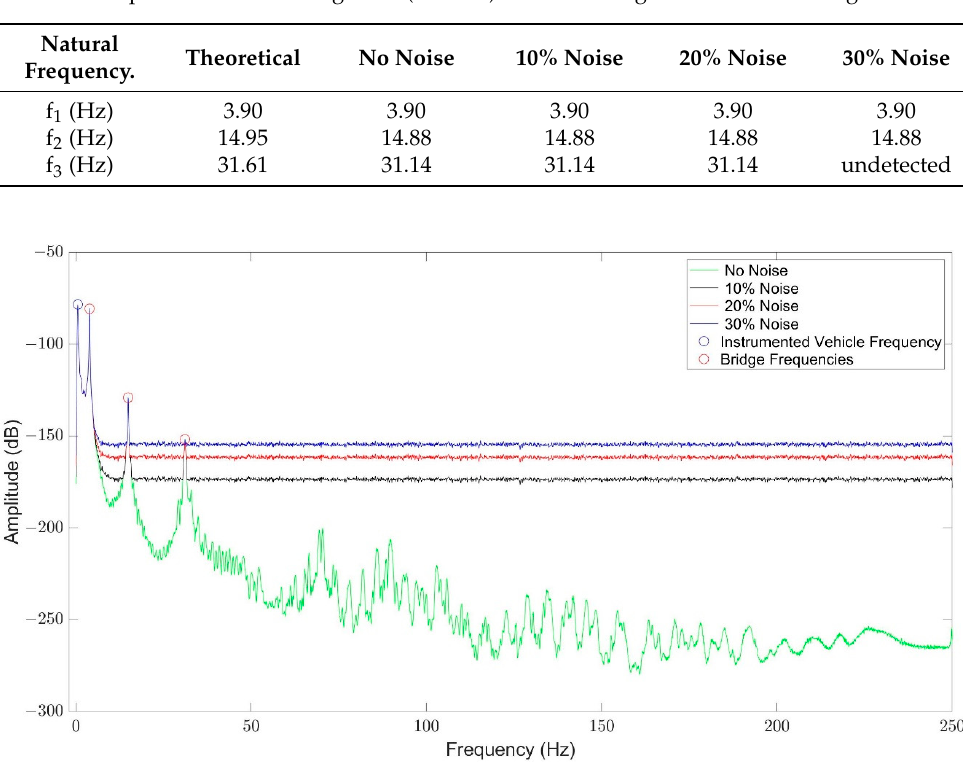
Figure 6. First singular value plots at increasing noise level. Table 7. Comparisons between the theoretical normalized modal displacements of the bridge and the identified values in the presence of road roughness (Class A) and increasing noise levels affecting the data. Instrumented Vehicle